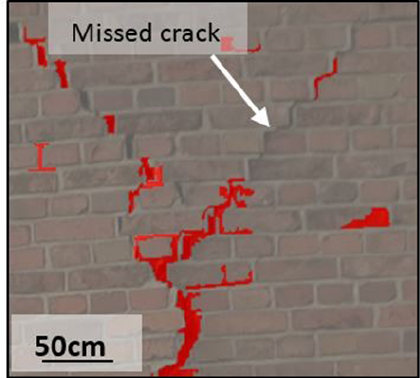
Figure 10. Result of the two-step segmentation of a concrete façade. Scale approx. Figure 11. Example of misclassified crack due to segmentation problems. Scale